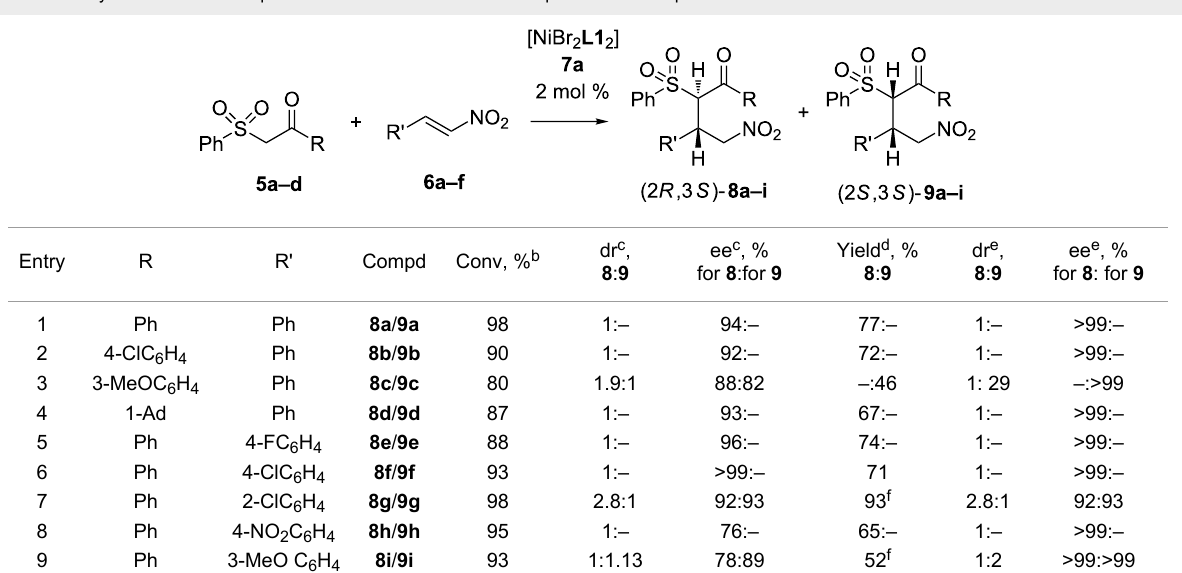
Table 3: Asymmetric addition of β -ketosulfones to nitroalkenes in the presence of complex 7a a .